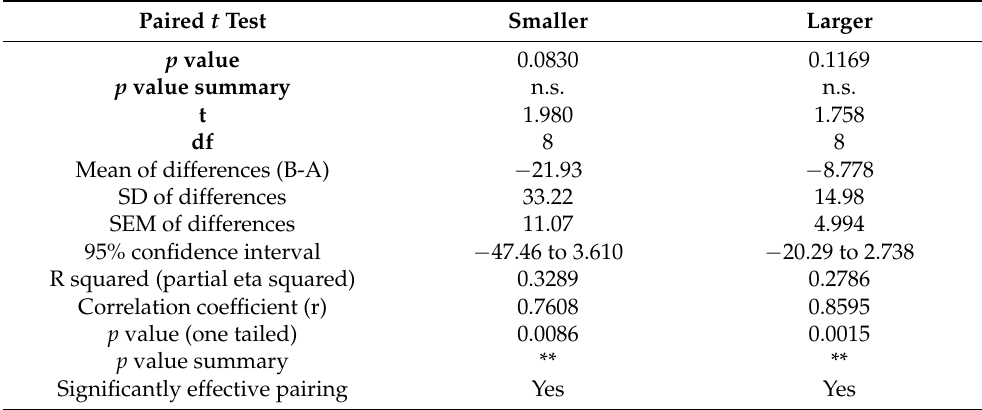
Table 1. Paired t -test (two-tailed p value) to compare the larval survivorships (A-B vs. C-D) in smaller and larger tanks. ** indicates p <